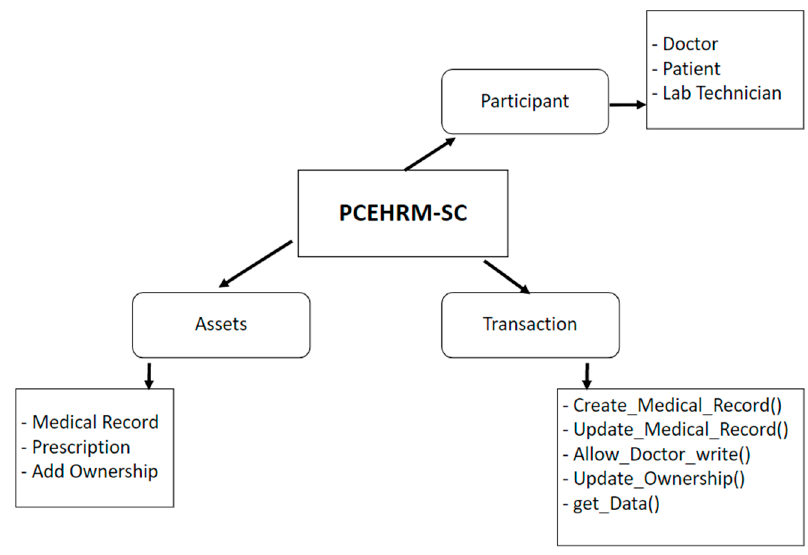
Figure 11. Proposed business ecosystem.